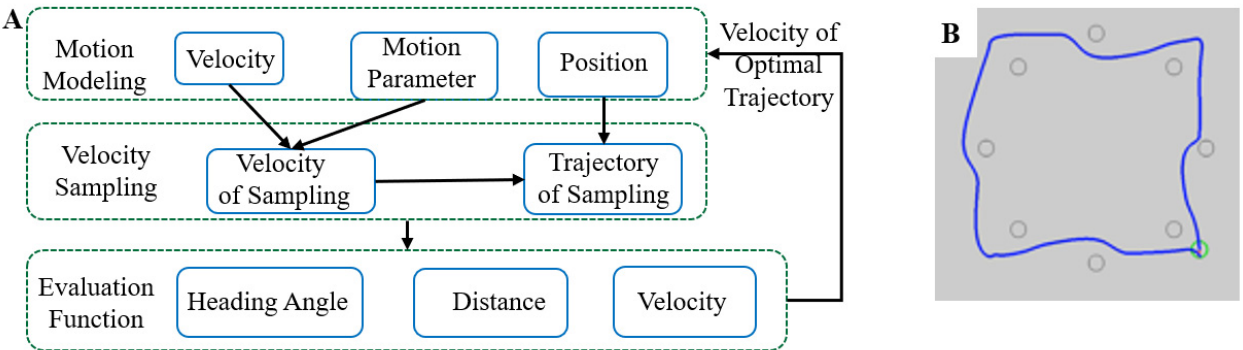
Figure 3. ( A ) Overall framework of DWA. ( B ) The simulation result of obstacle avoidance path plan- ning. path